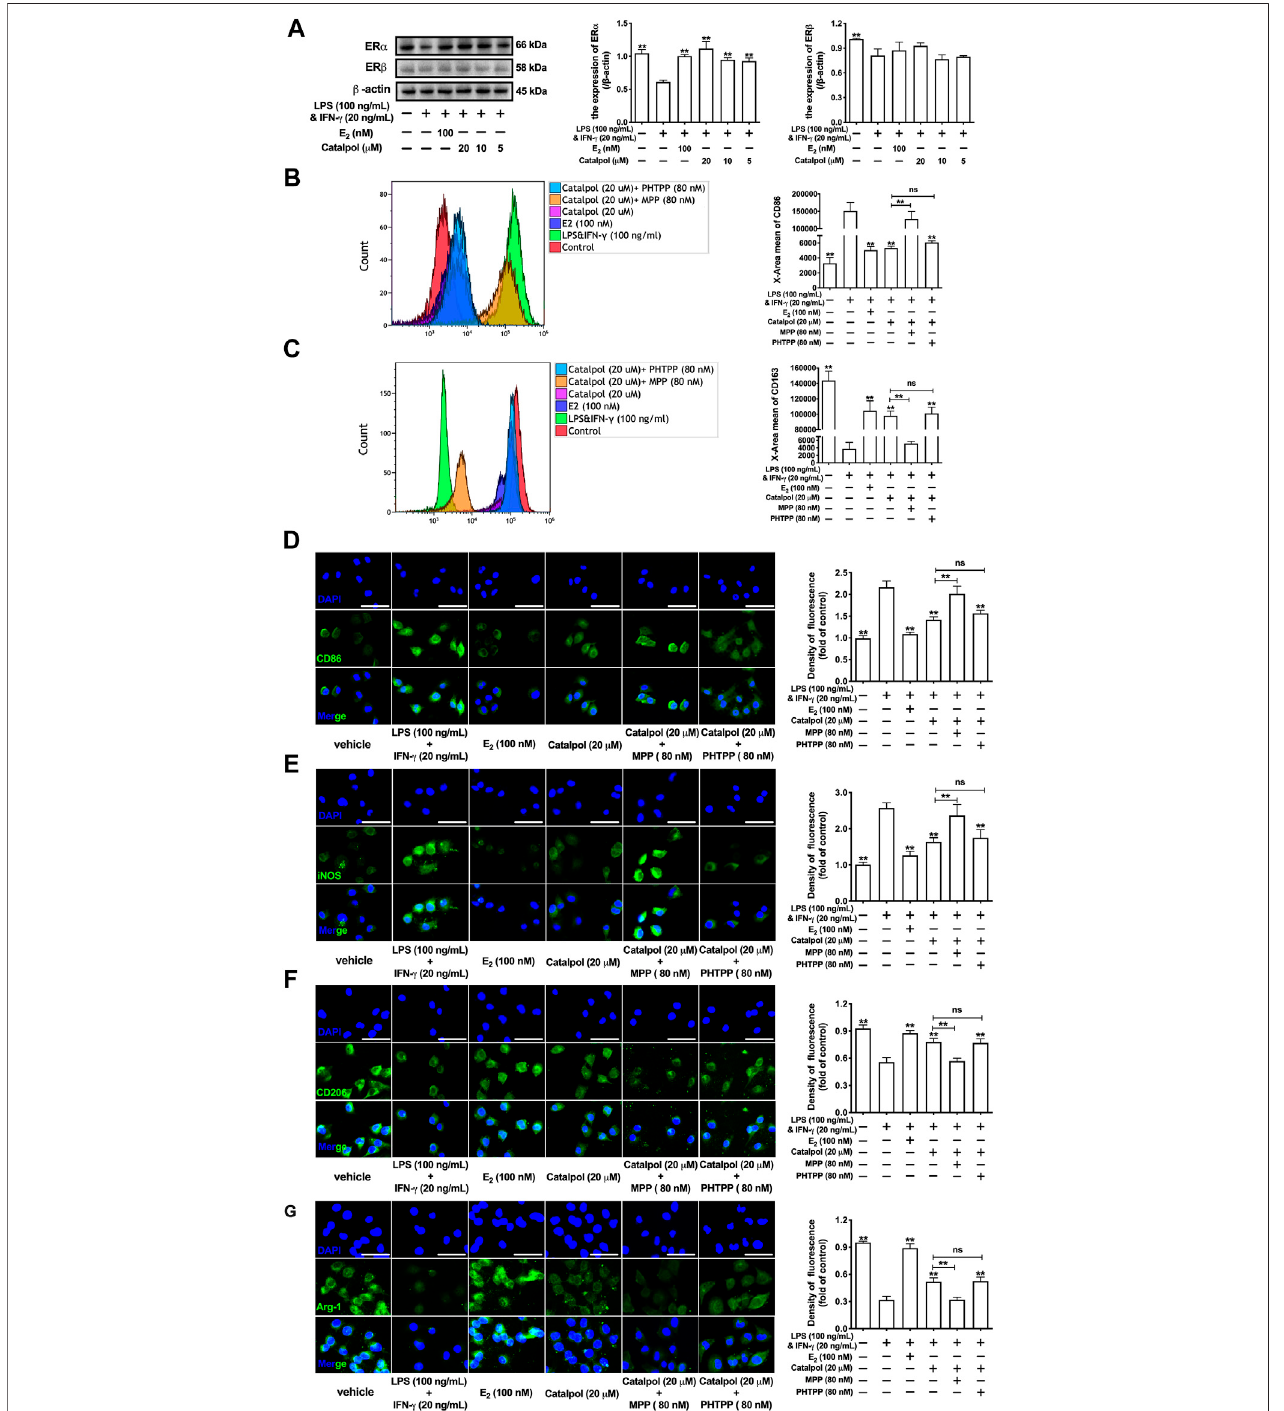
FIGURE 3 | Catalpol inhibited M1 macrophage polarization through regulating ER α . (A) Effects of catalpol on the expressions of ER α and ER β ( n (cid:2) 3); (B, C) With MPPandPHTPP,thelevelofM1macrophagemarkersCD86andM2macrophagemarkersCD163weredetectedbyFACS( n (cid:2) 3); (D,E) WithMPPandPHTPP,effects of catalpol on the expressions of M1 macrophage markers (CD86 and iNOS) were stained by immuno fl uorescence ( n (cid:2) 3); (F, G) With MPP and PHTPP, effects of catalpol on the expressions of M2 macrophage markers (CD206 and Arg-1) were stained by immuno fl uorescence ( n (cid:2) 3).